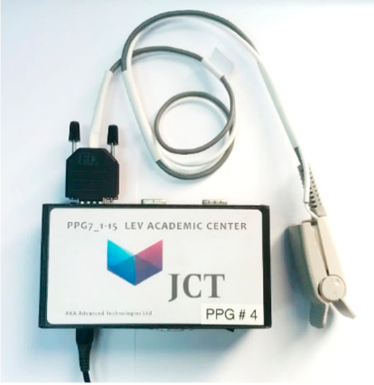
Figure 3. Photographs of the Jerusalem College of Technology (JCT) probes for use with an adult’s finger ( left ) and for use with a newborn’s foot or child’s finger ( right ). Light is emitted from one component of the probe and the light transmitted through finger/foot is collected by a detector that is placed on the other side of the finger/foot. PD—photodetector.